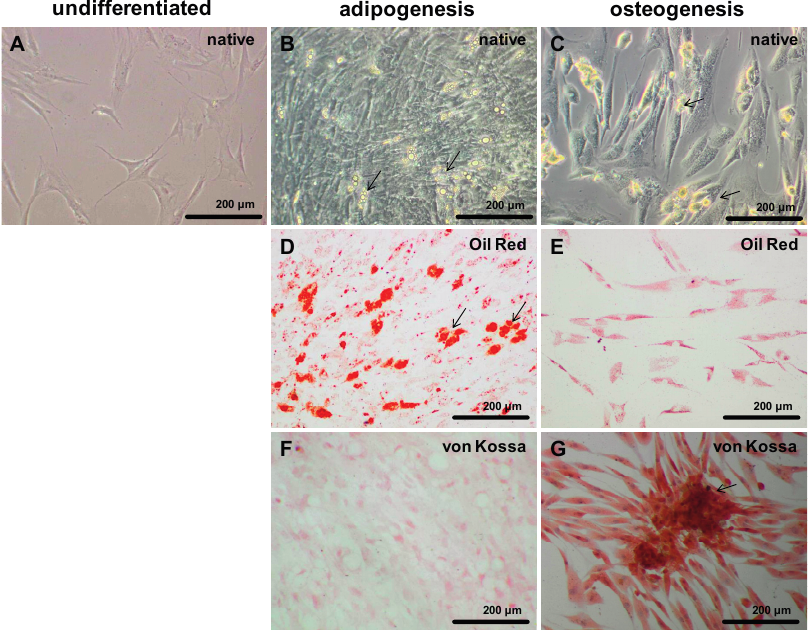
Figure 3. Adipogenic and osteogenic differentiated MSCs. Invert microscopical images of undifferentiated ( A ), adipogenic ( B , D , F ) and osteogenic ( C , E , G ) differentiated MSCs in monolayer culture. The cells were adipogenically and osteogenically differentiated for 21 days. Adipogenic differentiated cells revealed multiple fat vacuoles ( B , D ) which were red after oil red staining ( D , arrows). Osteogenic differentiation of MSCs led to granulated elongated cells ( C , E , G ) which were von Kossa positive ( G ) and formed clusters of extracellular matrix deposits ( C , G , arrows). Images of a representative experiment are shown. Scale bars = 200 µm.